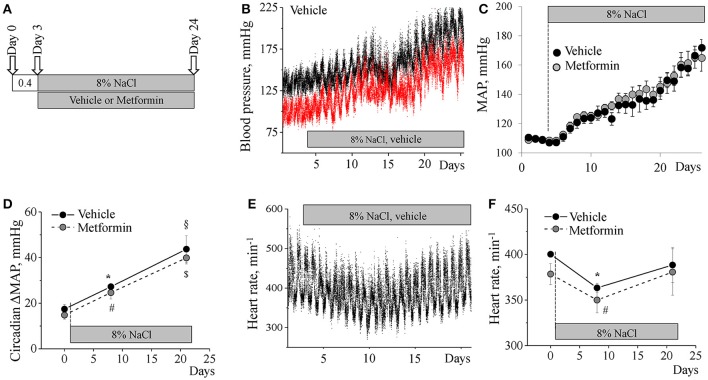
Metformin does not alter the development of SS hypertension. (A) Experimental protocol for BP recording. Continuous BP acquisition via catheters was performed in conscious Dahl SS rats placed on an 8% NaCl diet and subjected to an intravenous infusion of metformin (n = 9) or vehicle (n = 6). (B) Representative systolic (black) and diastolic (red) blood pressure recordings from a vehicle-treated animal. Data were averaged in 1 min intervals. (C) Mean arterial blood pressure (MAP) in the vehicle- and metformin-treated groups. (D) Metformin does not affect MAP circadian dipping increase during development of hypertension. (E) Representative heart rate trace acquired from a vehicle-treated animal. (F) Lack of effect of metformin on heart rate in experimental animals. *,#p < 0.05 vs. 0.4% NaCl; §,$p < 0.05 vs. 8 days on 8% NaCl.